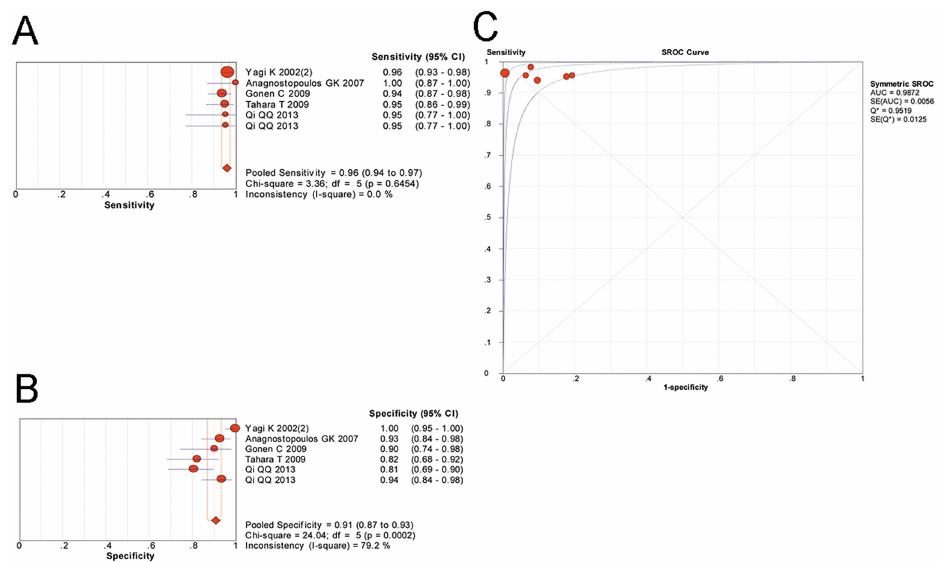
Fig 5. The diagnostic performance of a “pit plus vascularpattern” classification in the gastric corpus by magnifying endoscopy in predicting H . pylori infection. (A), pooledsensitivity; (B), pooledspecificity; (C), summary receiveroperatingcharacteristic curve for diagnosisby magnifyingendoscopy.CI, confidence interval; AUC, area under the curve; SE, standard